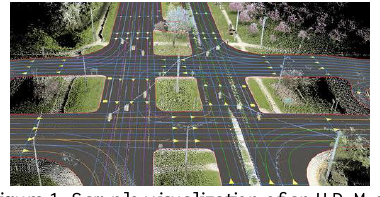
Figure 1. Sample visualization of an HD Map